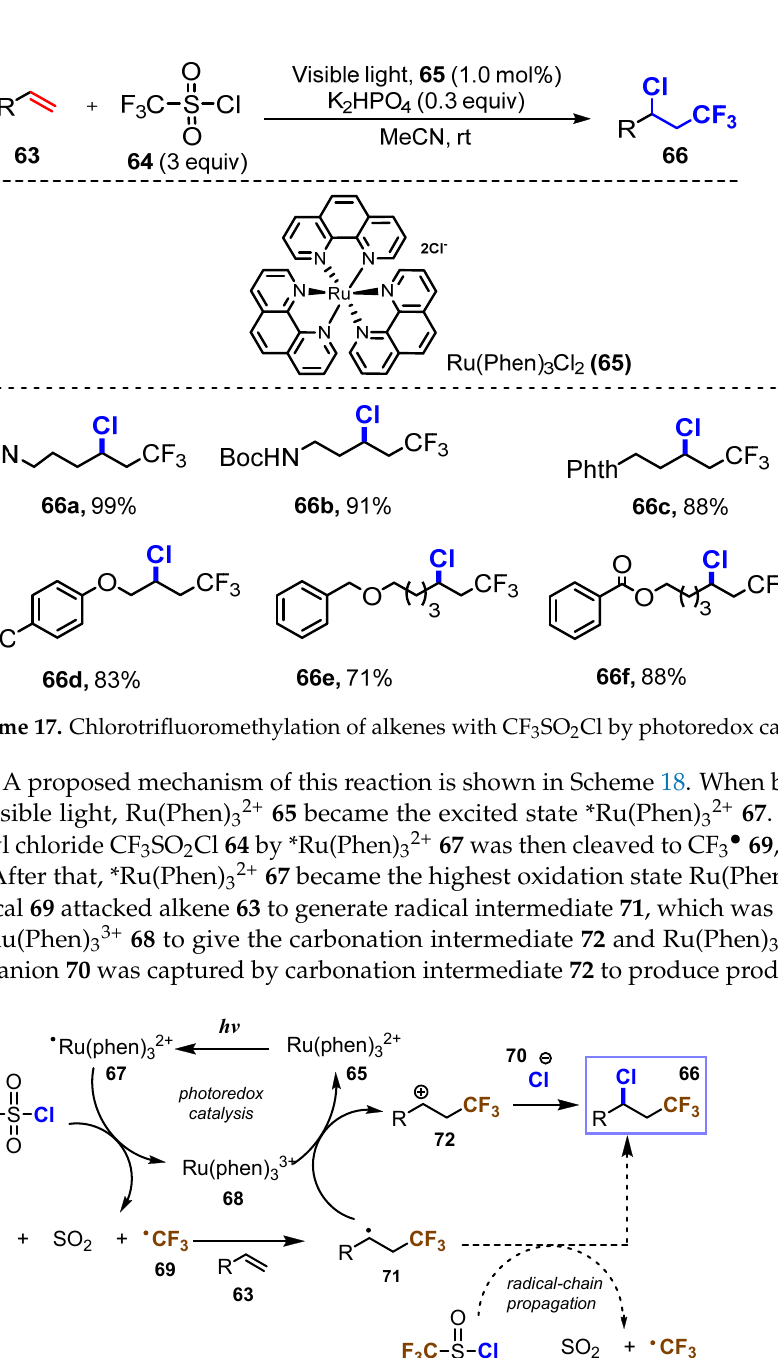
Scheme 18. Proposed mechanism of chlorotrifluoromethylation of alkenes.